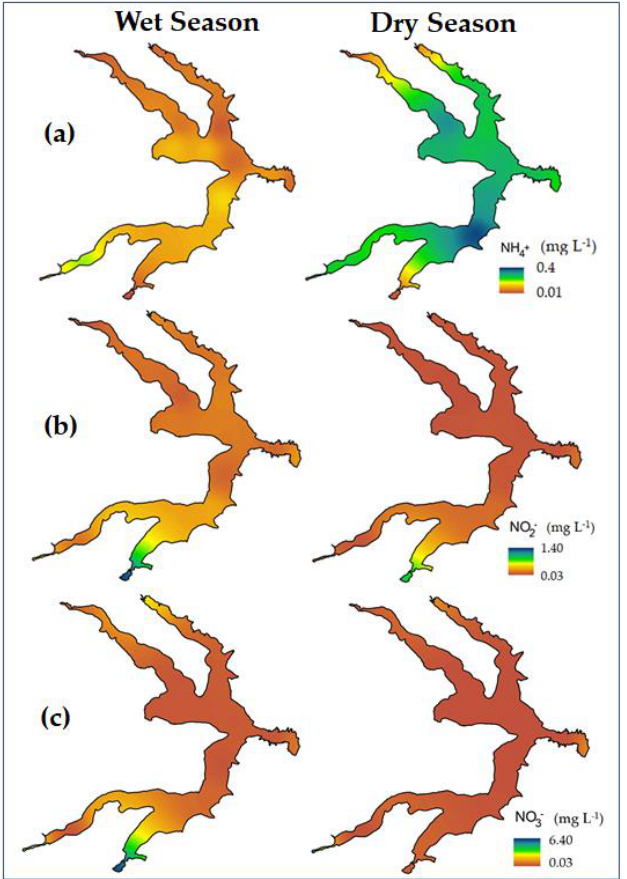
Figure 8. Spatial distribution of water quality variables: ( a ) NH 4+ , ( b ) NO 3 - , and ( c ) NO 2 − for wet and dry season.